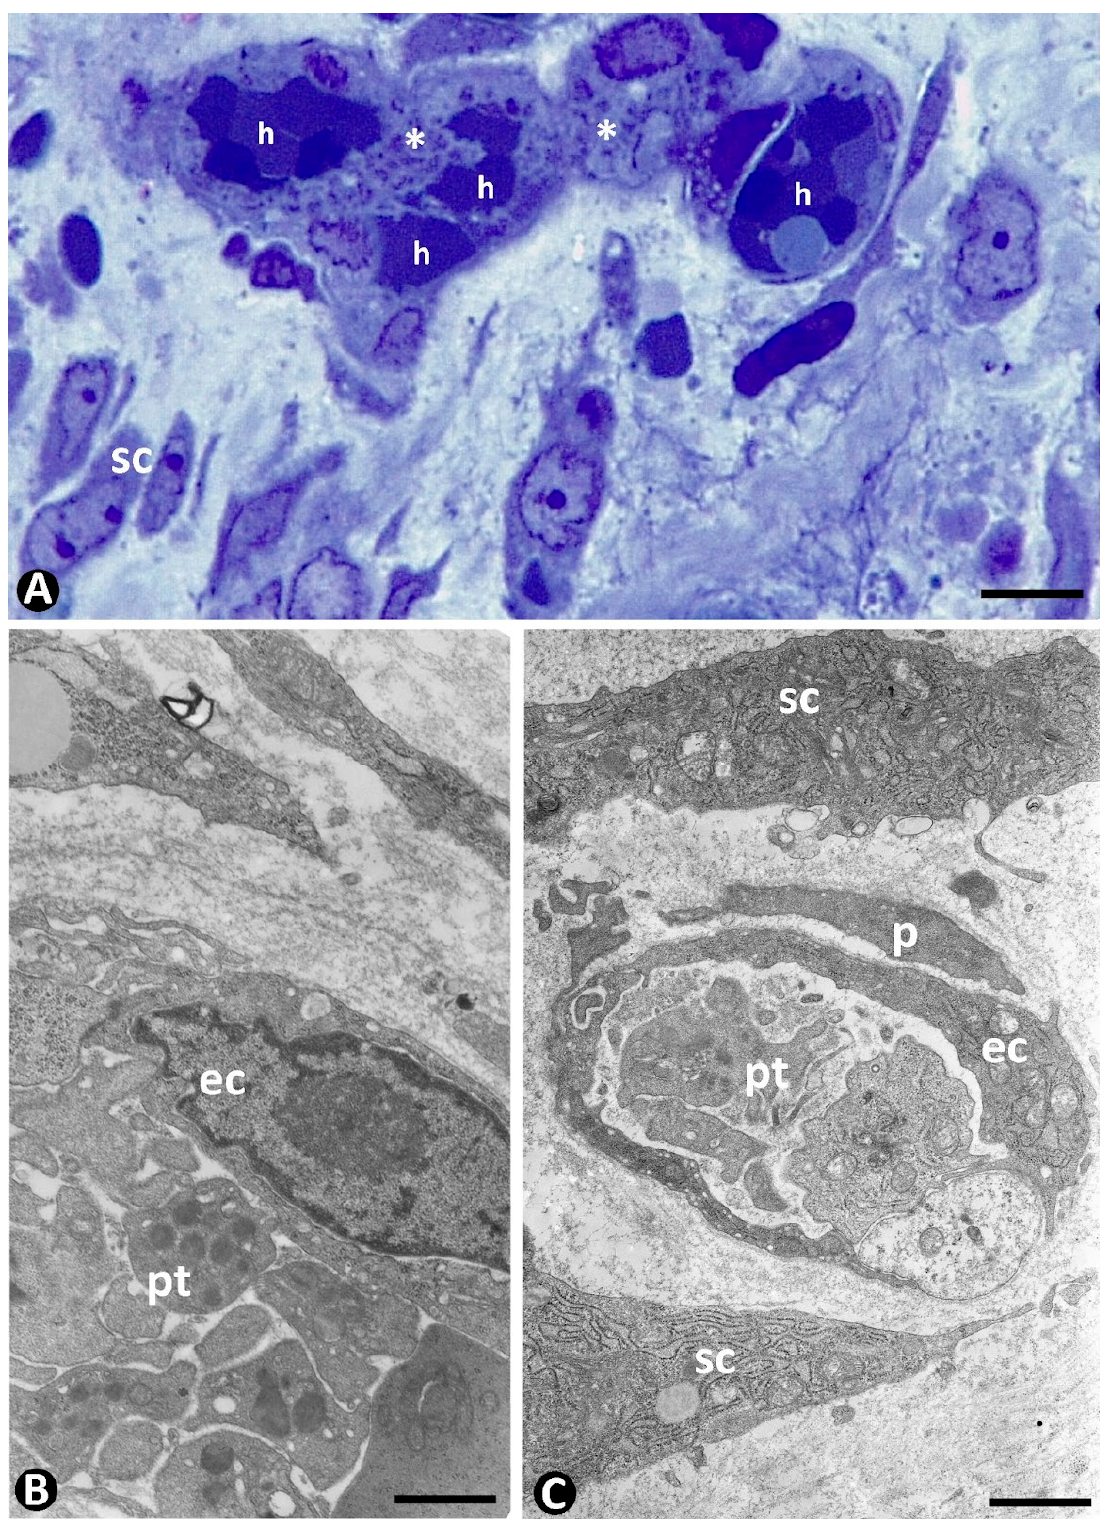
Figure 8. Intravascular accumulation of platelets during vessel regression. Platelet aggregates (asterisks) and red blood cells (h) in regressing vessels and interstitial/stromal cells in a semithin section. ( B , C ): Ultrastructural images of intravascular platelets (pt). Endothelial cells: ec. Pericyte: p. Stromal cells: sc. ( A ): Semithin section. Toluidine blue staining. ( B , C ): Ultrathin sections. Uranyl acetate and lead citrate. Bar: ( A ): 10 µm; ( B , C ): 1 µm.